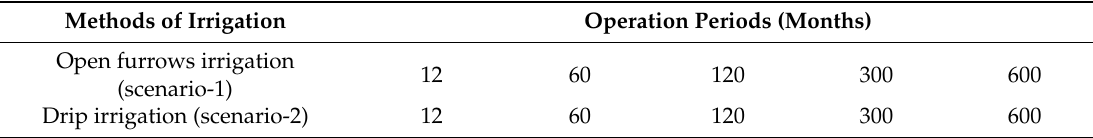
Table 2. Alternative irrigation methods and operation periods.